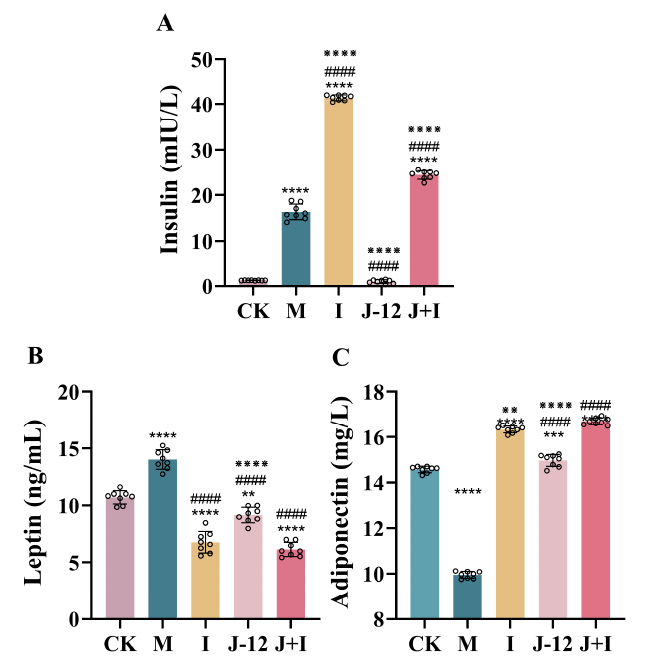
Figure 3. J-12 improved insulin and leptin resistance and activated adiponectin in rats with hyper- glycemia in pregnancy. ( A ) Serum insulin levels. ( B ) Serum leptin levels. ( C ) Serum adiponectin levels. CK: control group, rats fed a standard diet. M: model group, rats fed an HFD and administered a single STZ injection prior to pregnancy and then fed a standard diet during pregnancy. I: insulin group, rats fed an HFD and administered a single STZ injection prior to pregnancy and then fed a standard diet and injected with insulin during pregnancy. J-12: J-12 group, rats fed an HFD and administered a single STZ injection prior to pregnancy and then fed a standard diet during pregnancy. Rats administered the J-12 suspension (1 × 10 9 CFU daily) by gavage during the entire experimental period. J + I: J-12 plus insulin group, rats fed an HFD and administered a single STZ